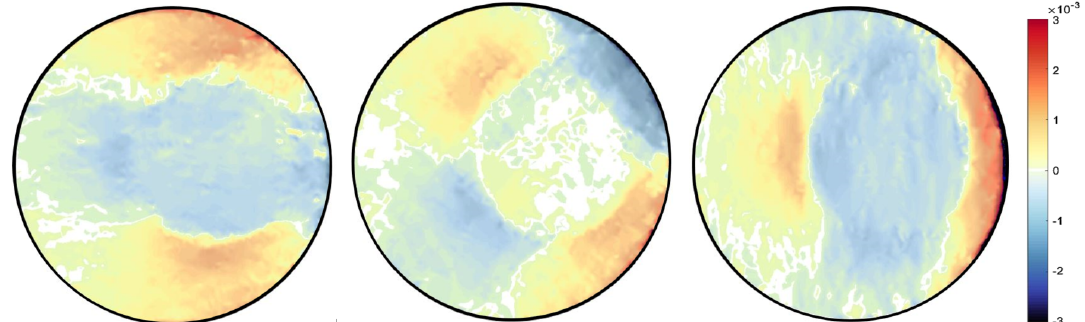
Figure 11. Regularised strain field ε xx , ε xy , ε yy respectively for unstructured mesh type, with S as stiffness matrix and α = 0.001.